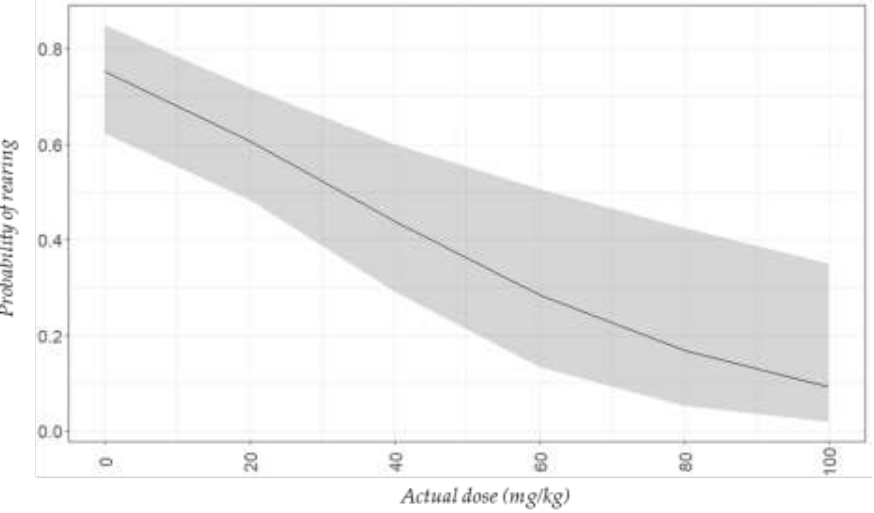
Figure 2. Predicted plot (±95% confidence interval) for probability of rearing (indicative of aver- sion) during euthanasia with CO 2 according to the actual doses of tiletamine-zolazepam in C57BL/6